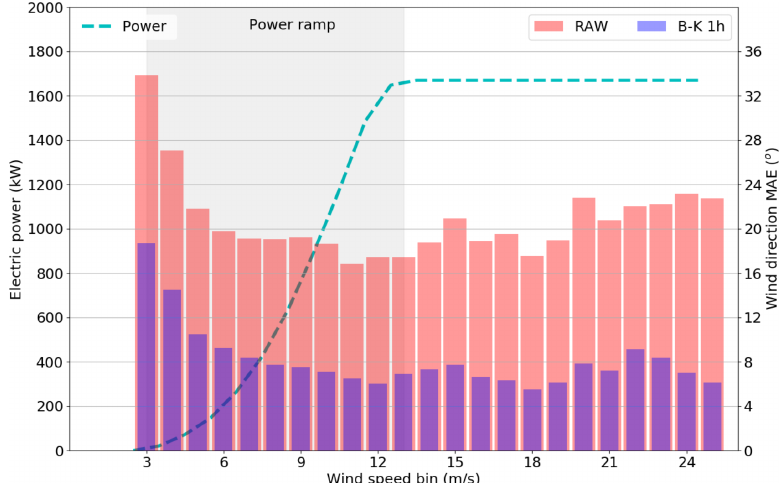
Figure 10. ECOTECNIA 74 wind power curve (density = 1.112 kg/m 3 , height = 975 m, temperature = 9 ◦ C), cyan line. Each bar of the figure represents the wind direction MAE associated with wind speed bins with a bandwidth of 1 m/s both for RAW (red) and K-B 1 h (blue). Table 5. WD MAE for all the experiments and different persistence periods in power ramp winds. Power Ramp Winds (49.7%) Wind Dir. MAE ( ◦ ) North Center South Total Per. 10 min